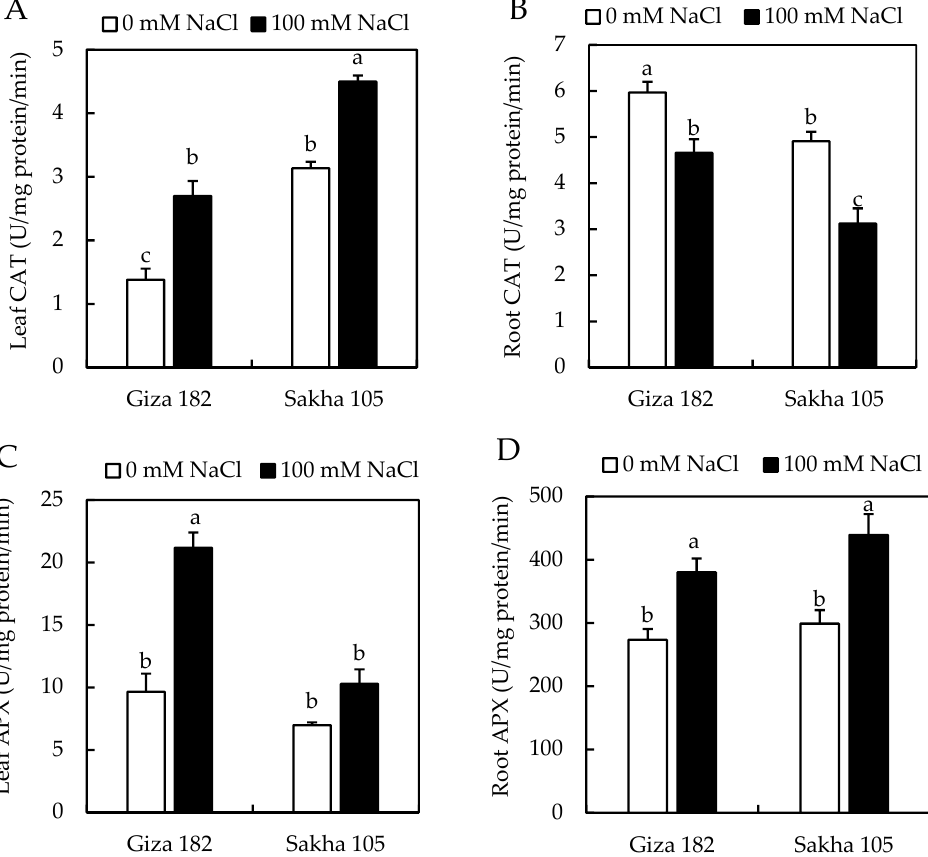
Figure 6. Activity of catalase (CAT) ( A , B ) and ascorbate peroxidase (APX) ( C , D ) in the roots and leaf blades of Giza 182 and Sakha 105 under control conditions and 100 mM NaCl stress for 14 days. The bars represent means ± SE (standard errors) ( n = 4). The bars with the same letter on the top are not significantly different ( p ≤ 0.05).